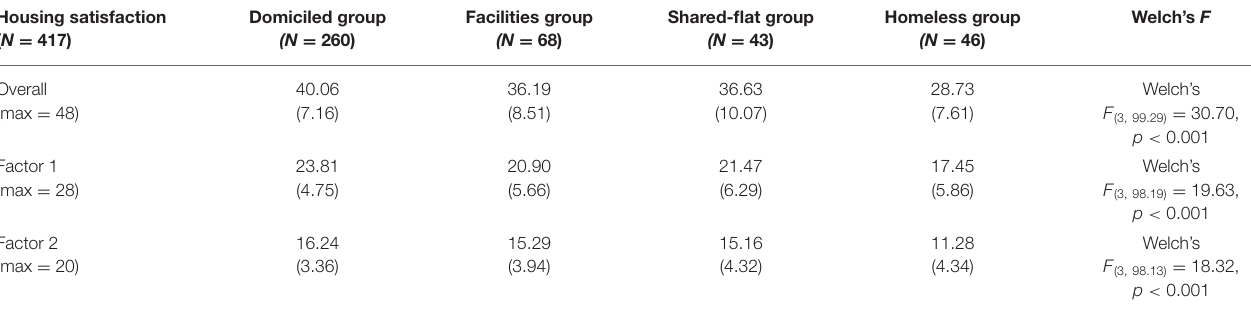
TABLE 3 | Descriptive housing satisfaction, including mean scores and standard deviation, and Welch’s ANOVA